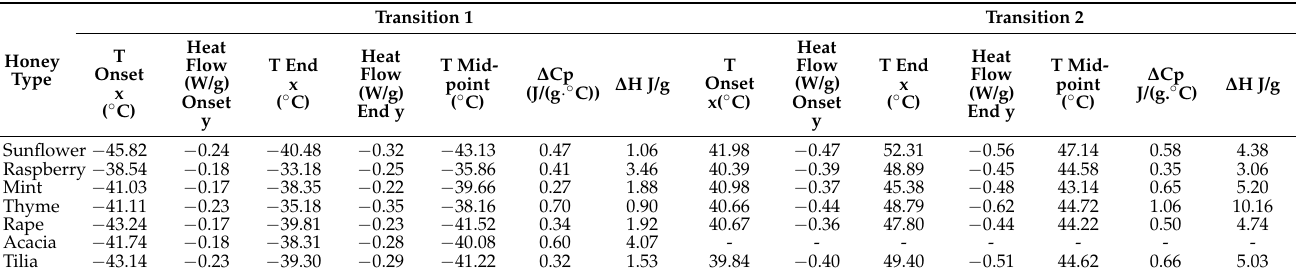
Table 2. Thermal characteristics of honey